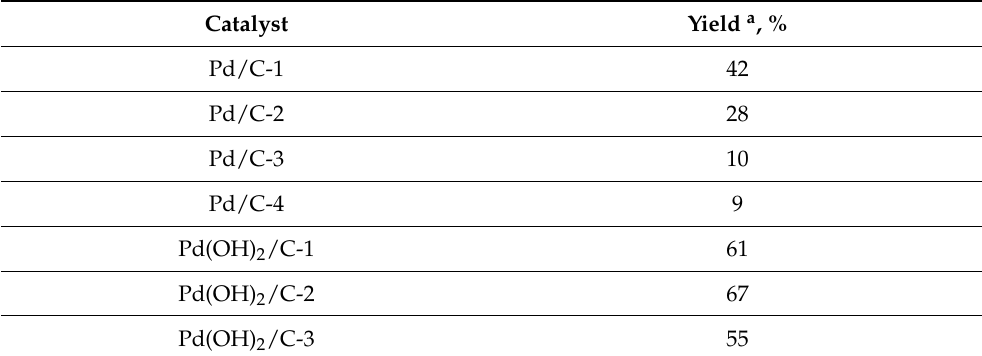
Table 2. Yields of 1,2,3,4-tetrahydroquinoline in presence of the composites (T = 50 ◦ C, p = 30 bar, t = 4 h, methanol was used as solvent). Pd loading in the reaction mixture was 1 mol. % in all cases. Catalyst Yield a , % Pd/C-1